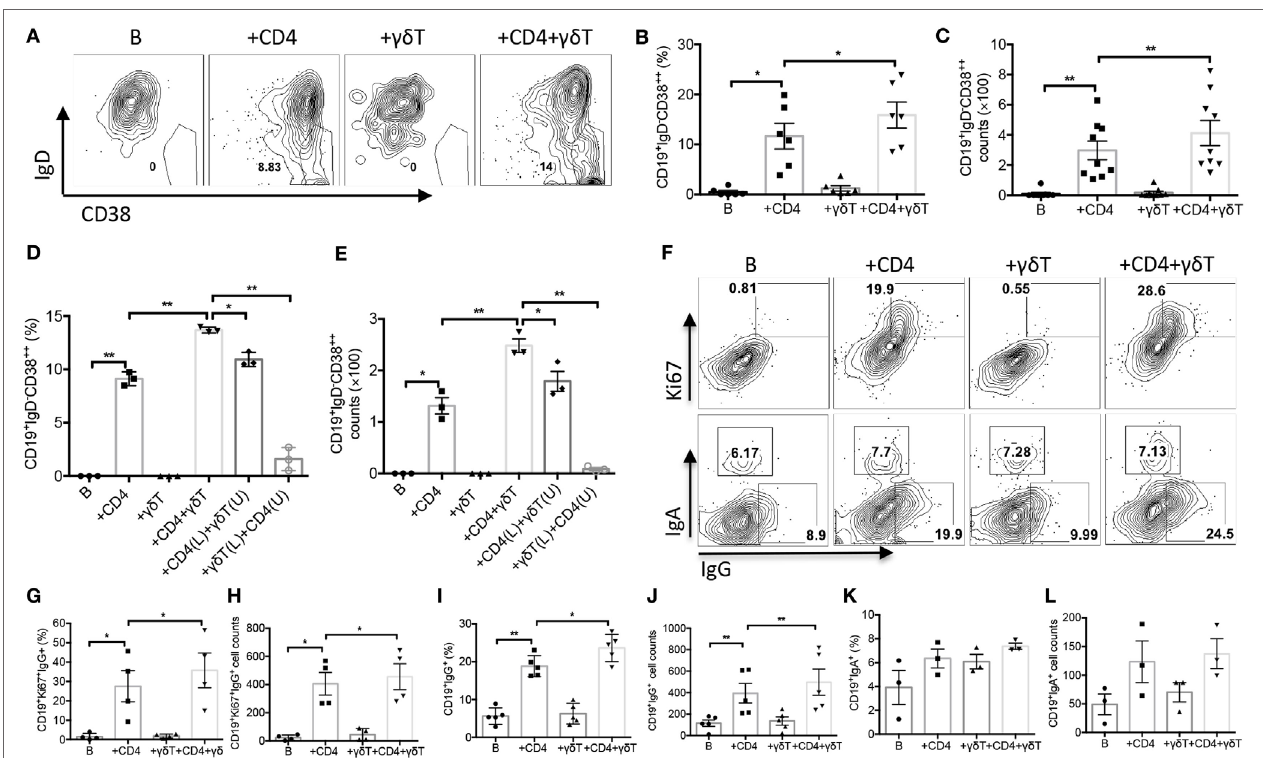
FigUre 4 | V γ 9V δ 2-T cells promoted plasma cell (PC) differentiation and B cell immunoglobulin class switching. Naïve CD4 T cells were cultured with UV-H9N2 virus-pulsed dendritic cells for 4–5 days, then, the activated CD4 T cells were cultured with CD19 + B cells from same donor with or without V γ 9V δ 2-T cells